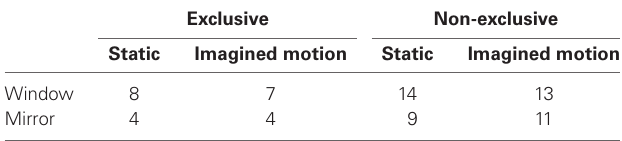
Table 1 | Number of participants (out of 20) who selected the correct carriages in each condition . Exclusive Non-exclusive